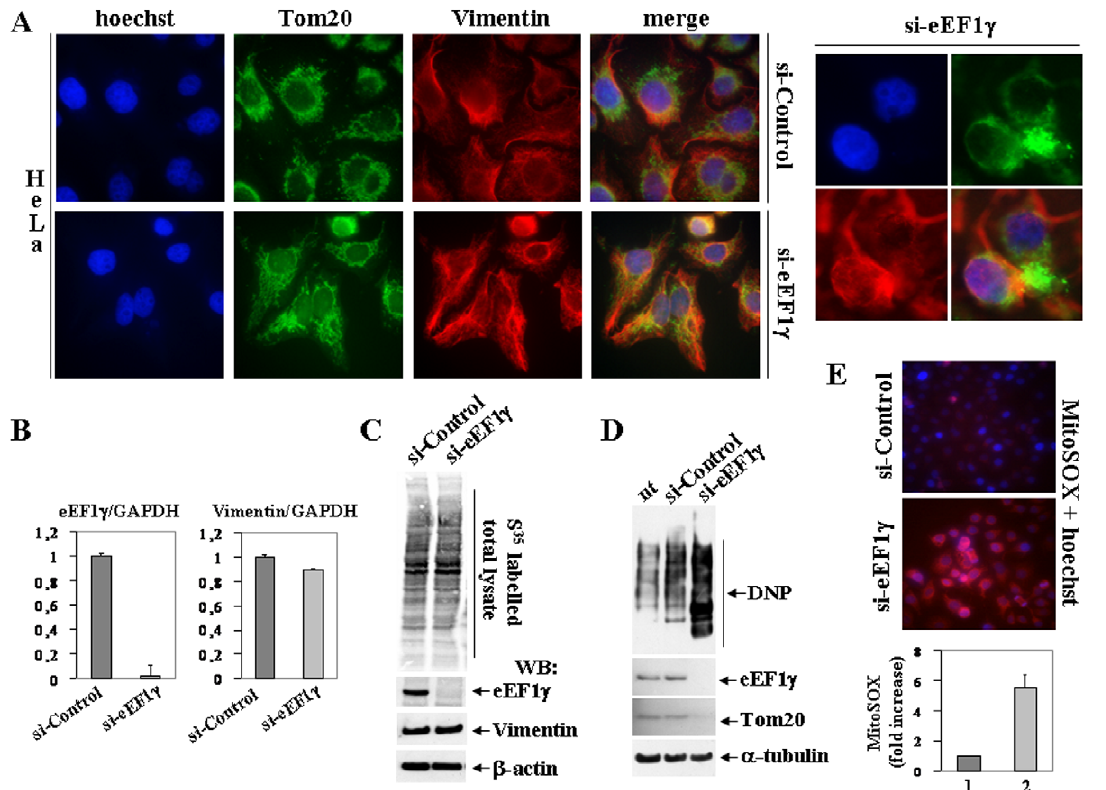
Figure 5. Analysis of eEF1 c depletion. A : Indirect immunofluorescence obtained with the anti-Tom20 rabbit polyclonal and the anti-Vimentin monoclonal antibody in HeLa cells treated with siRNA-Control or with siRNA-eEF1 c . On the right side a higher magnification image of eEF1 c -depleted HeLa cells focusing on the formation of mitochondrial dysfunctional clusters. B : Real time RT-PCR analysis of the eEF1 c (left) and Vimentin (right) mRNAs in HeLa cells (siRNA-Control and siRNA-eEF1 c ). The gene expression ratio between eEF1 c and GAPDH and between Vimentin and GAPDH are shown as means 6 SD from three independent experiments performed in triplicate. C : The global protein synthesis of HeLa cells, transfected with either siRNA-Control or siRNA-eEF1 c and supplemented with S 35 labelled methionin and cystein, was visualized by autoradiography of the total protein lysates blotted to nitrocellulose membrane. Then the same membrane was incubated with the anti-eEF1 c rabbit polyclonal and the anti- Vimentin mouse monoclonal antibodies. Anti- b -actin monoclonal antibody was used to normalise the amount of protein loaded on the gel. D : Induced carbonylation pattern (oxidation level) of HeLa cells: untreated, treated with either siRNA-Control or siRNA-eEF1 c . The total protein carbonylation pattern was visualised by western blot with the anti-DNP antibody. Depletion of eEF1 c by siRNA was monitored using the anti-eEF1 c rabbit polyclonal antibody. The levels of Tom20 protein were monitored using the anti-Tom20 polyclonal antibody. Anti-alpha-tubulin monoclonal antibody was used to normalise the amount of protein loaded on the gel. E : Representative florescence images of HeLa cells treated with either siRNA-Control or siRNA-eEF1 c (top). The cellular level of superoxide was visualized by the MitoSOX (red) mitochondrial Superoxide Indicator staining. Nuclei were stained with Hoechst (blue). Histogram reporting fold of increase of MitoSOX fluorescence of siRNA-eEF1 c treated cells (lane 2) versus siRNA-Control treated cells (lane 1), shown as means 6 SD from three independent experiments (bottom). doi:10.1371/journal.pone.0014481.g005 fragments approximately 500 bp in length. Equal amounts of chromatin from each sample were immunoprecipitated over night with the anti-eEF1 c rabbit polyclonal antibody (Bethyl Laborato- ries, Inc.). Immunoprecipitation with no specific immunoglobulins (Santa Cruz) was performed as a negative control. DNA representing 0.005% of the sonicated chromatin solution (input) and 10% of the immunoprecipitated sonicated chromatin solution were amplified using the human Vimentin specific primers, hVIM forward (5 9 -CCGCAGCCCCGAGACCGCCGCGCA-3 9 ) and hVim reverse (5 9 -GTCCCGTTACTTCAGCGCTGGGCT-3 9 ), the human thymidine kinase specific primers, hTK forward (5 9 - GCCCCTTTAAACTTGGTGGGCGG-3 9 ) and hTK reverse (5 9 -TTGCGCCTCCGGGAAGTTCACG-3 9 ), the DNA poly- merase b specific primers, hPol b forward (5 9 -TCAGAATCAA- GATCGCACTCCCGT-3 9 ) and hPol b reverse (5 9 -GCGCT- TGTTGTGACGTCACGCGTCC-3 9 ). PCR conditions were: 30 cycles at 95 u C for 45 s, 60-67 u C for 30 s, 72 u C for 30 s and a final extension at 72 u C for 5 min.